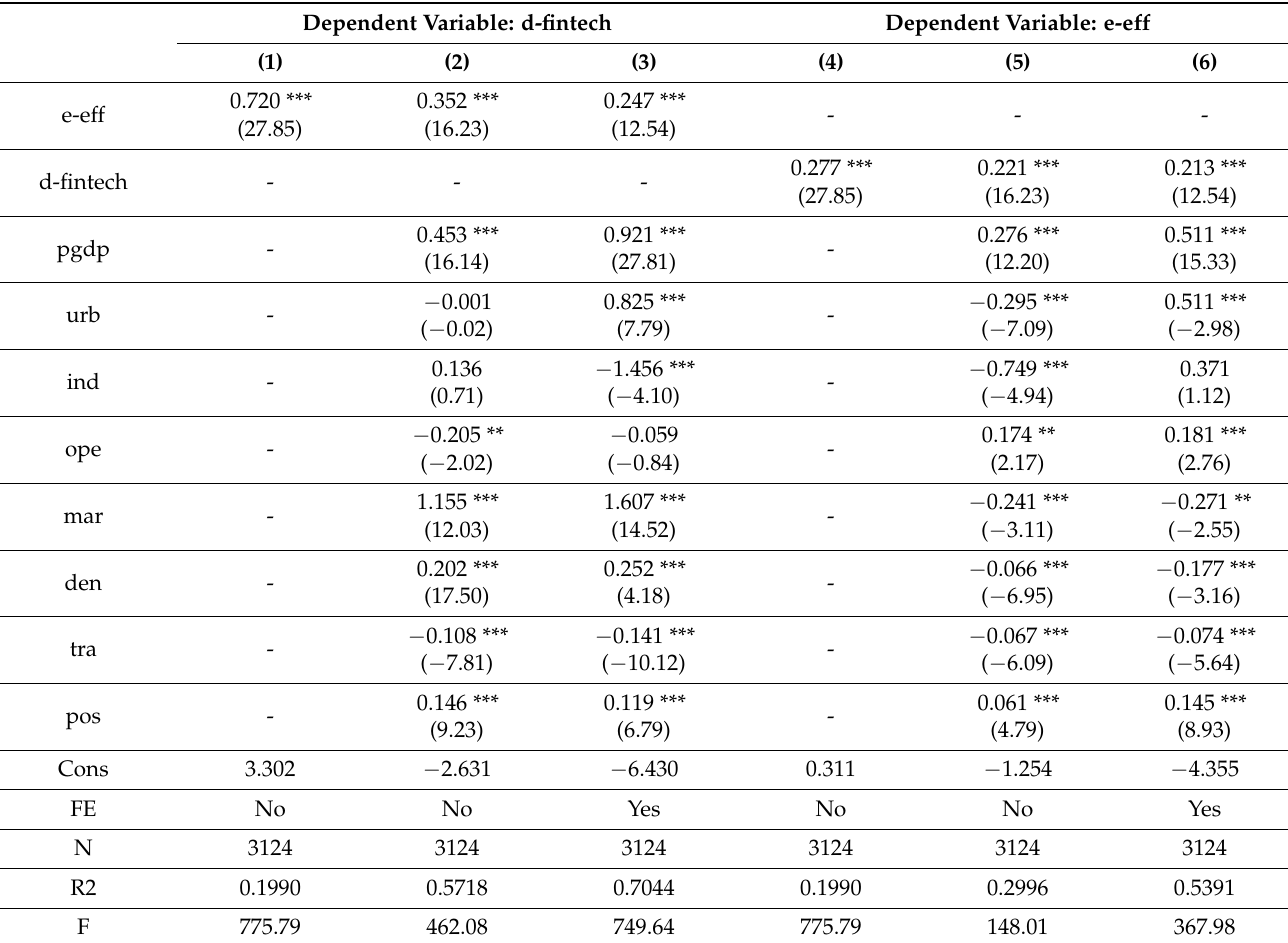
Table 4. Results of benchmark regression without spatial